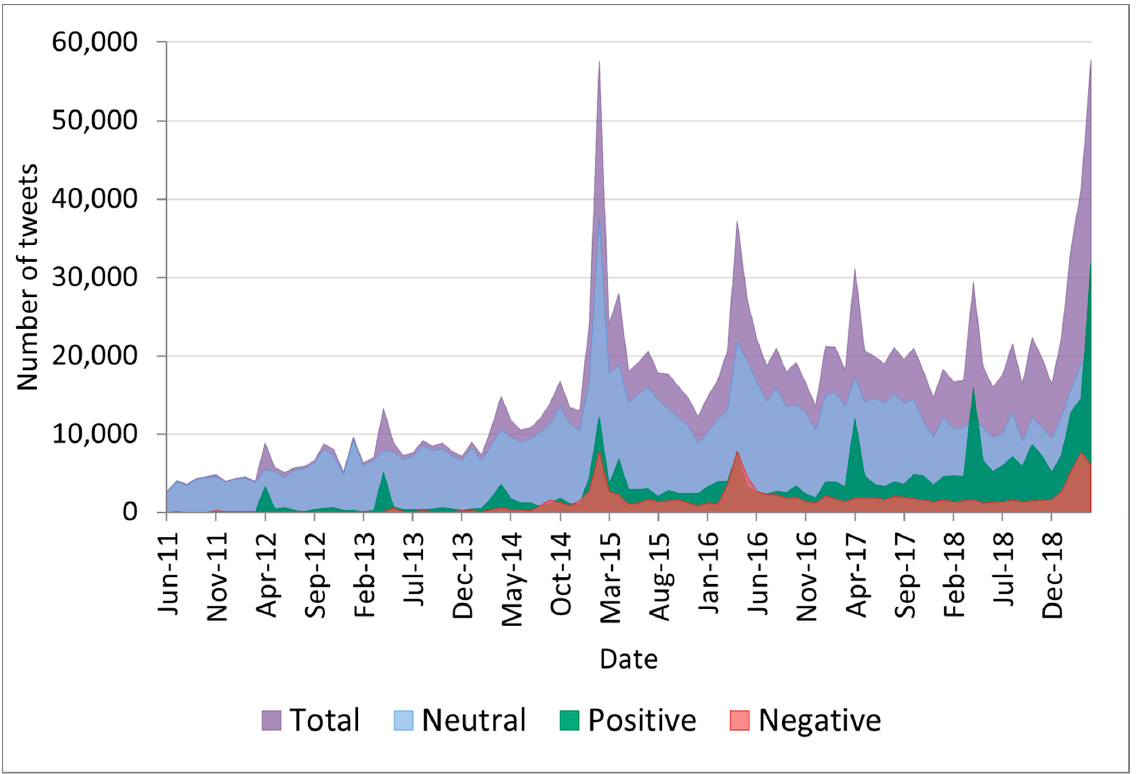
Figure 1. Area chart for the number of tweets classified by sentiment (June 2011–April 2019). The relative frequency of neutral tweets showed a decreasing tendency in the study period ( p = 0.00, R 2 neutral group = 0.7479, linear model), while the proportion of positive tweets and the proportion of negative tweets increased ( p = 0.00, R 2 positive group = 0.6902 and R 2 negative group = 0.6187, exponential model) (Figure 2). In April 2018 and April 2019, the proportion of neutral tweets dropped to a minimum of 40.47% and 34.51%, respectively, while the proportion of positive tweets exceeded 50% (53.81% and 54.97%, respectively. The negative group only accounted for a percentage of more than 20% of the dataset once, in April 2016